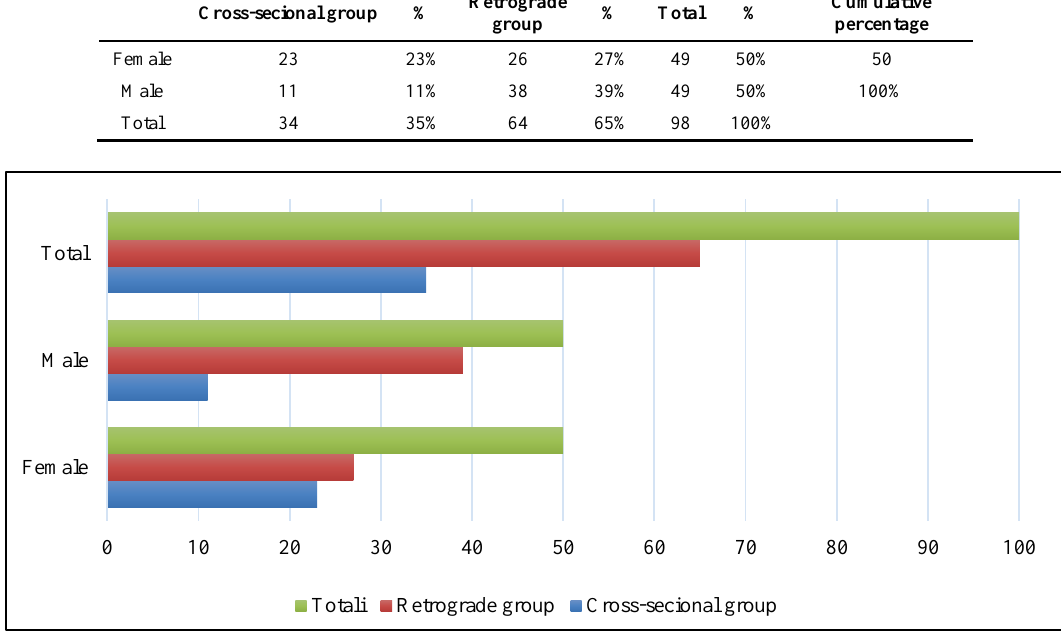
Table 1. Data on the gender of patients included in the study: The first group and the second group